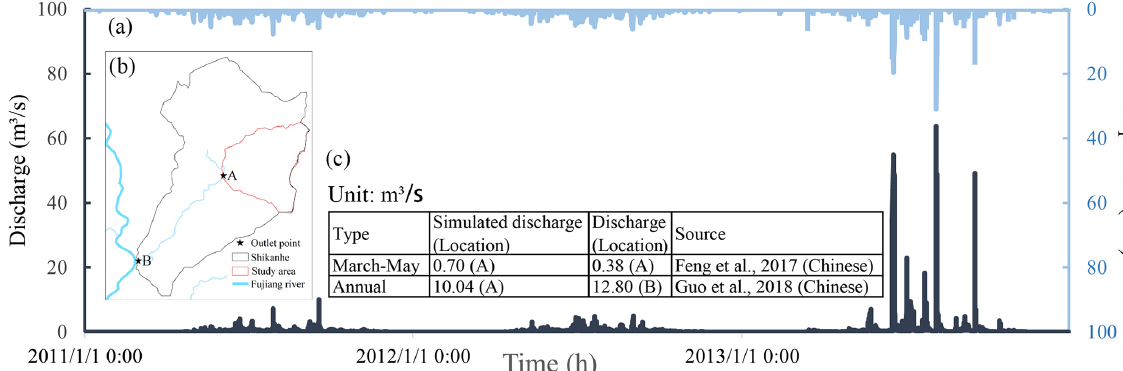
of 27 . 1 × 10 4 and 16 . 9 × 10 4 m 3 of loose material is